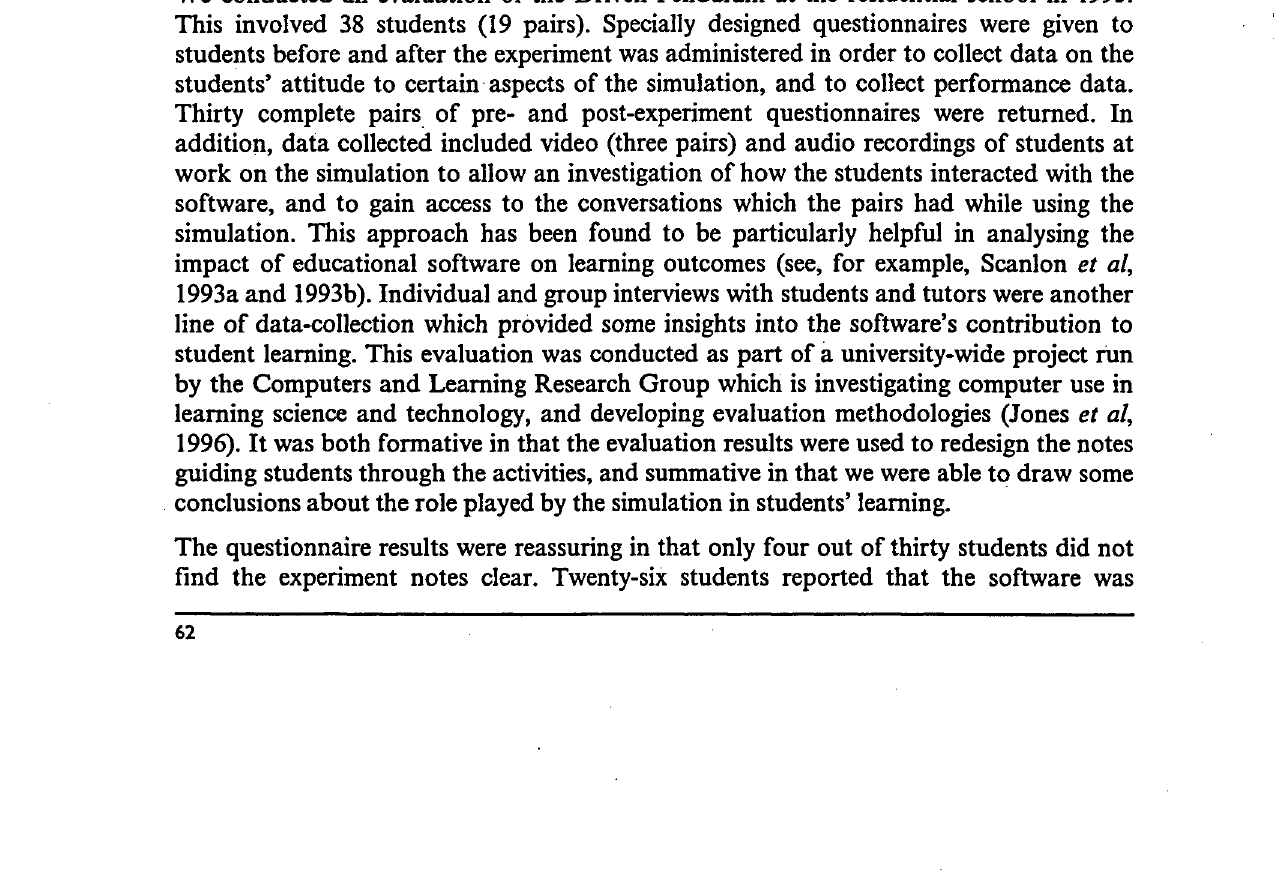
figure /: The three windows of the simulation